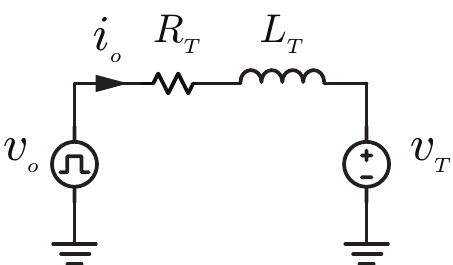
Figure 10. The simplified power circuit model with the